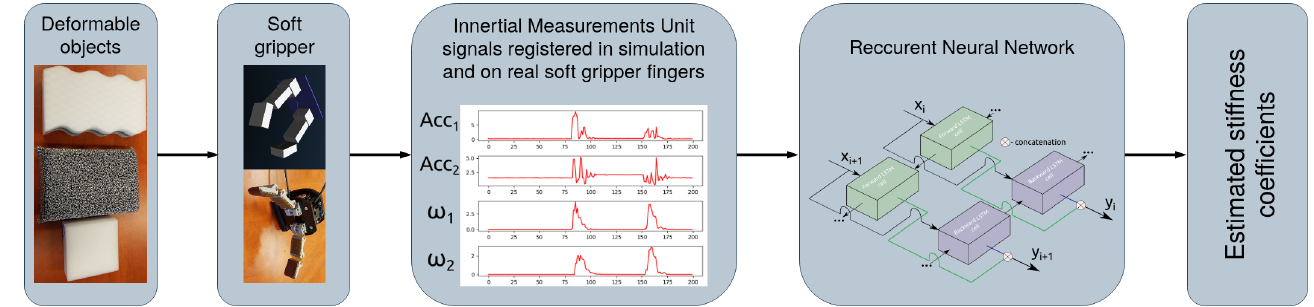
Figure 1. Schematic diagram of the proposed system. The set of deformable objects is squeezed in simulation and with the real gripper. The data is registered from Inertial Measurements Units mounted on the gripper fingers. Recurrent Neural Network is performing deformable object stiffness coefficient regression based on registered data from